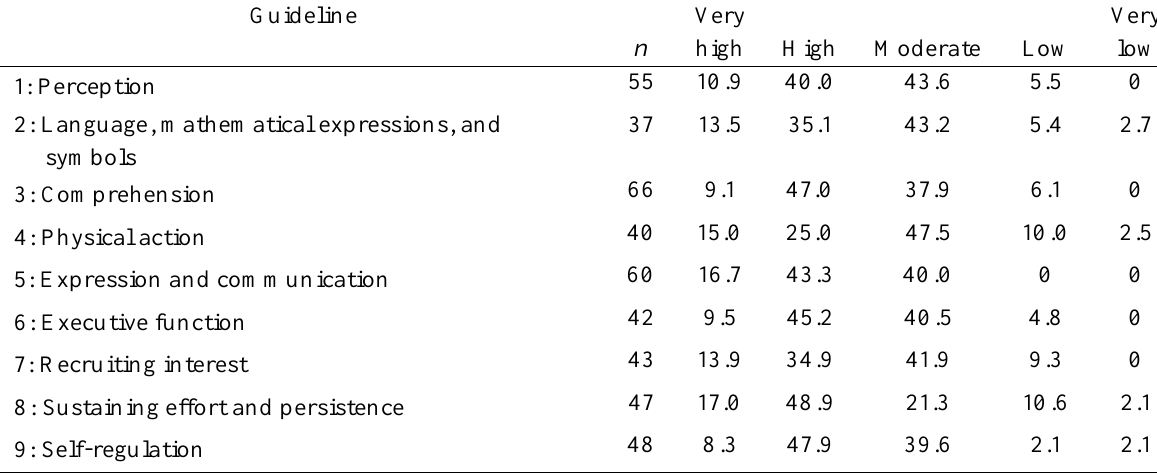
Respondents’ Self-Reported Level of Implementation of UDL Guidelines in Their Course Design Guideline